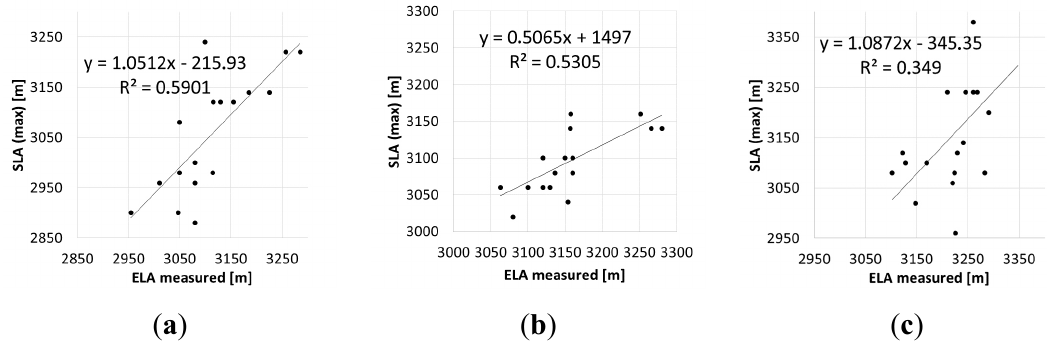
Figure 8. ELA measured versus the max SLA for years with at least two Landsat images. ( a ) Regression analysis for Hintereisferner, ( b ) for Kesselwandferner and (c) for Vernagtferner.